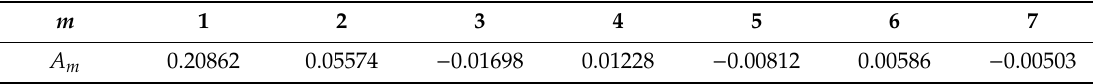
Table 3. The values of the coe ffi cients A m of the solution u ( 7 ) ( x , t ) (see Example 1). m